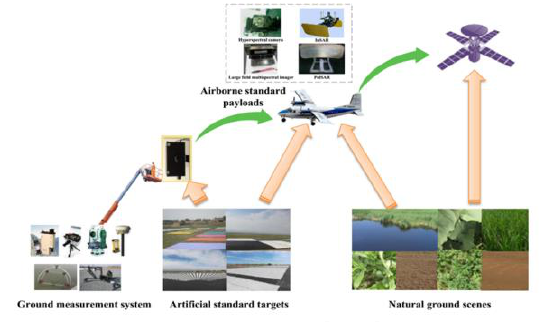
Figure 9. Stepwise Cal&Val system